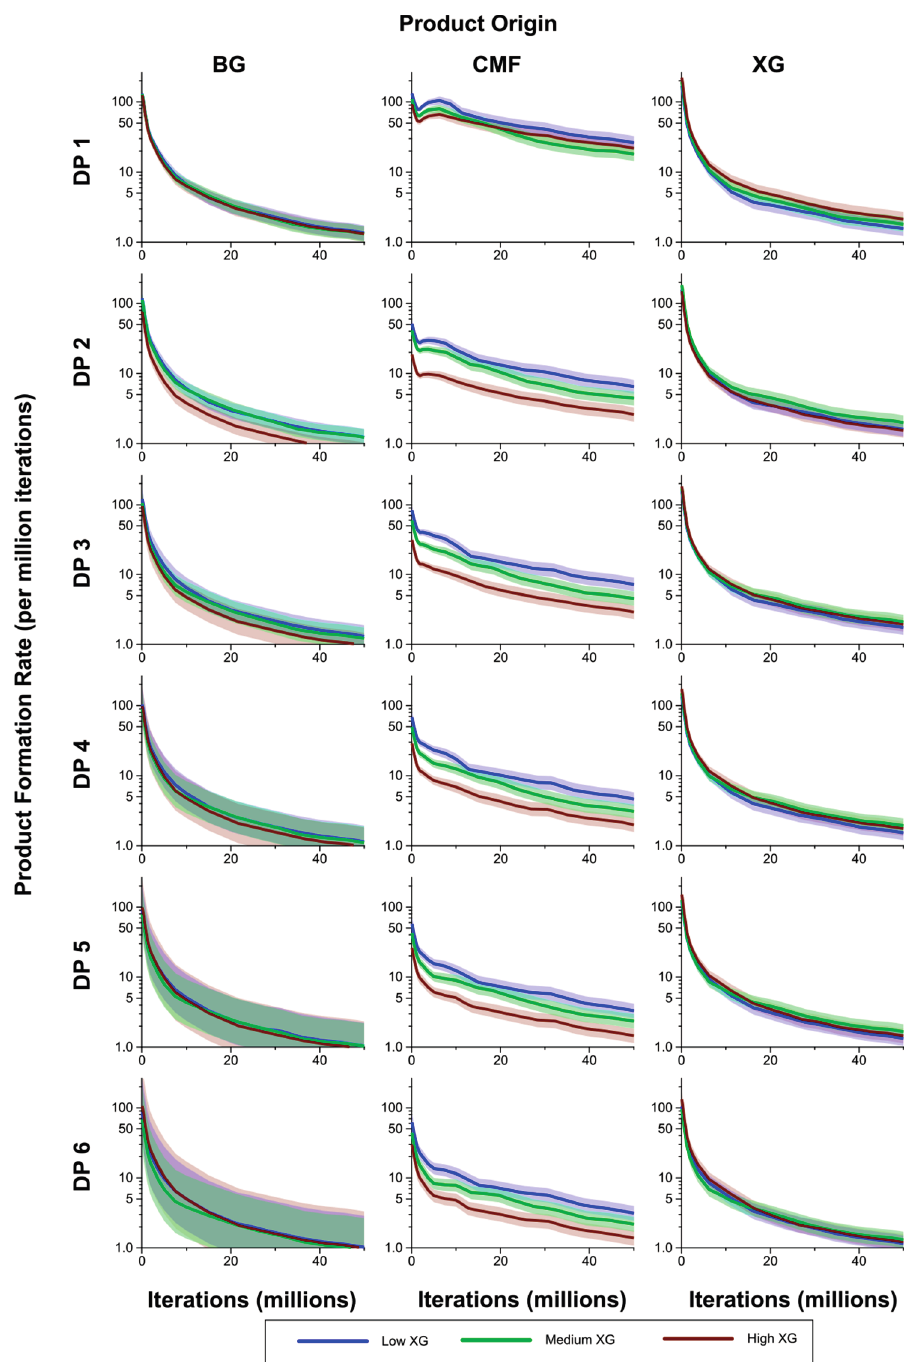
Figure 10. Breakdown products (monosaccharides and oligosaccharides) over time (iterations) for Low, Medium and High XG walls, showing rate of formation of products by DP from (1,3;1,4)- β -glucan (BG), CMF and XG. The shaded region represents a 95% Least Significant Interval so that any two of the three curves are significantly different at the 5% level where their bands do not overlap. The solid line in the middle indicates the mean